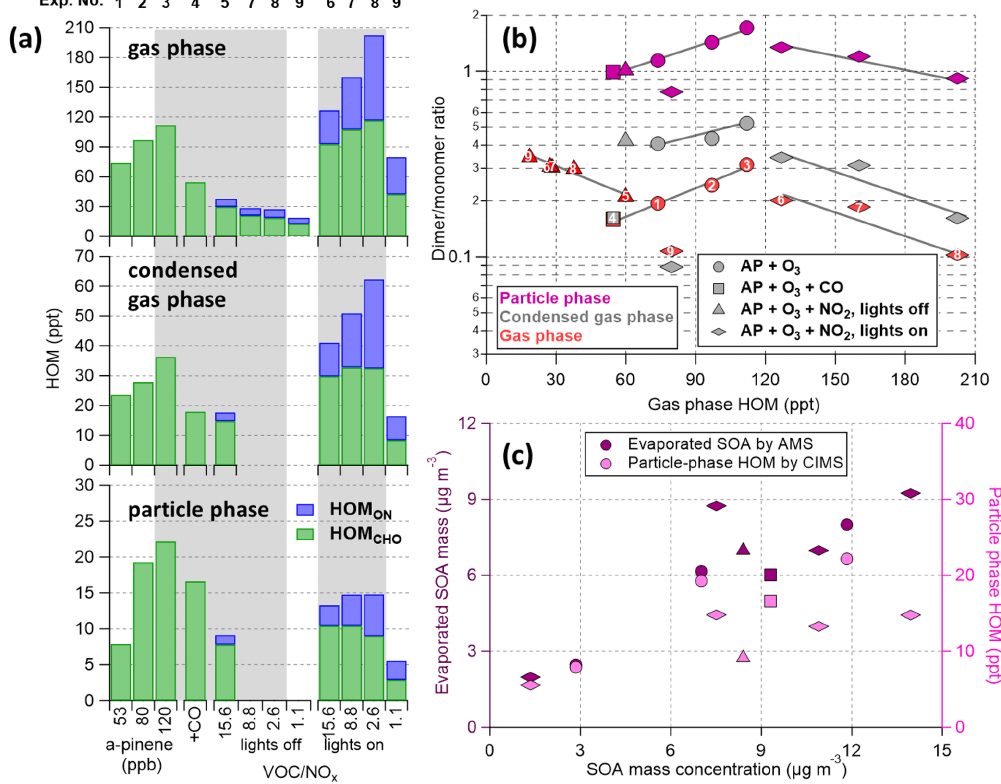
Figure 8. Summary of (a) total HOM concentrations estimated in the gas phase, condensed gas phase, and particle phase (different scales were used for different phases); (b) dimer to monomer (D / M, i.e., C 16 − C 20 / C 8 − C 10 ) ratios; (c) particle-phase HOM and SOA mea- surements. The evaporated SOA mass was calculated from AMS measurements (i.e., the mass difference between VIA and bypass modes). Experiment numbers are given in panels (a) and (b) . Shaded areas in panel (a) represent experiments with initial α -pinene concentrations of 120ppb. The HOM concentrations are given in absolute values here to be able to compare the different experiments more quantitatively, but the large uncertainties (at least a factor of 3) need to be kept in mind. The gas-phase HOM concentration is used as the x axis in (b) as a surrogate for the overall α -pinene reaction rate, which could not be plotted directly due to the lack of VOC measurement. Grey solid lines in panel (b) only serve as guides to connect experiments with similar